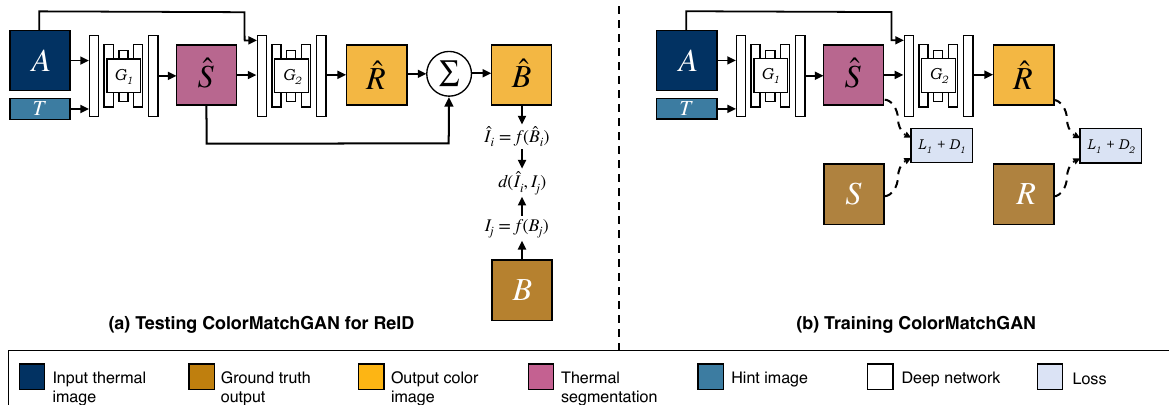
Figure 2. Overview of our ColorMatchGAN